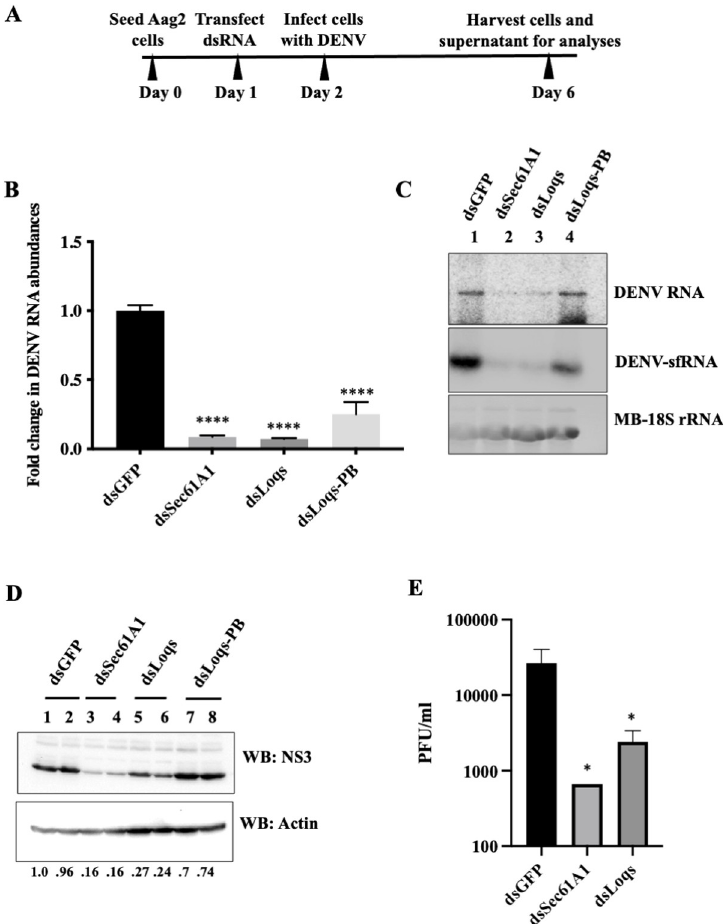
Fig 2. Effects of Sec61A1 and Loquacious depletion on DENV2 RNA and protein abundances, and viral titers. (A) Experimental outline. Mosquito Aag2 cells were transfected with double stranded RNAs (dsRNA) directed against GFP, Sec61A1, Loqs (targeting both PA and PB isoforms) or Loqs-PB mRNAs. 24 hrs post transfection, cells were infected with DENV2-NGC at an MOI of 0.1 and harvested 96 hrs post infection for analyses. (B) RT-qPCR measurement of DENV RNA abundances in dsRNA-treated cells plotted as fold change over treatment with dsGFP. Data was normalized to internal control RPL32 mRNA levels (n = 3, ���� p < 0.0001). (C) Effects of dsRNA treatment on DENV RNA and DENV subgenomic RNA (DENV-sfRNA) abundances, measured by Northern blot analysis. Methylene blue (MB) staining of rRNA was used as a loading control. Representative image from three independent experiments is shown. (D) Effects of dsRNA treatment on DENV NS3 and actin protein levels examined by western blot analysis. Numbers below the lanes represent the relative abundance of NS3 normalized against actin in each sample, as quantified by densitometric analysis using Image Lab 6.0. Representative image from three independent experiments is shown. (E) Effects of dsRNA treatment on infectious viral titers determined by plaque forming assays (PFU/ml, n = 4, � p <